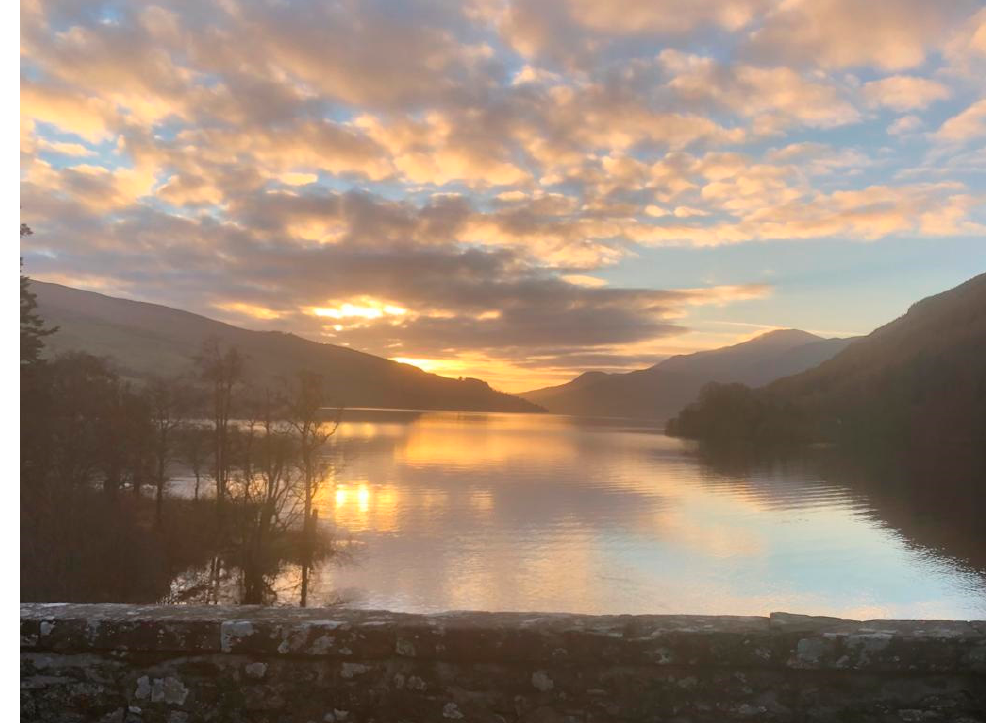
Figure 4. Different ways of seeing.